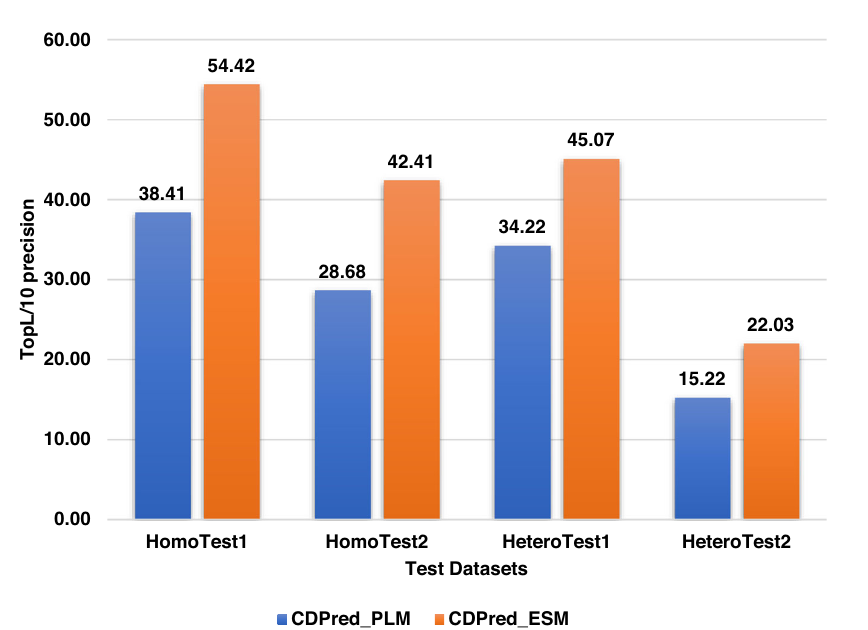
Fig. 1 | The histogram of the precision of the top L/10 contact predictions for the heterodimers in the HeteroTest2 dataset. The X-axis is the four precision intervals from 0 to 100%. The Y-axis is the number of heterodimers